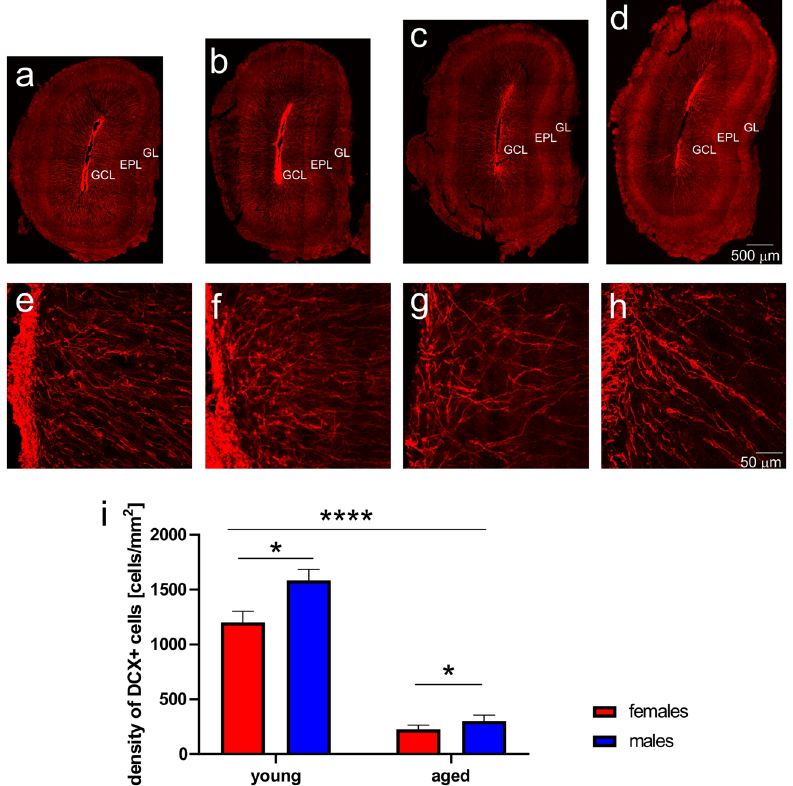
Figure 4. Localization of doublecortin (DCX) in the olfactory bulb (OB) of opossums. ( a – d ) DCX labeled neurons in the young female ( a ), young male ( b ), aged female ( c ) and aged male ( d ) OB. ( e – h ) High magnification images taken from images presented in ( a – d ), showing localization of DCX labeled cells in the granule layer ( e – h ). ( i ) Quantification of DCX immunolabeled cell density in the OB of young and aged oposumms. GL glomerular layer, EPL external plexiform layer, GCL granule cell layer. The scale bar in ( d ) refers to ( a – d ), and the scale bar in ( h ) refers to ( e – h ). In ( i ) * p = 0.018, ****p <